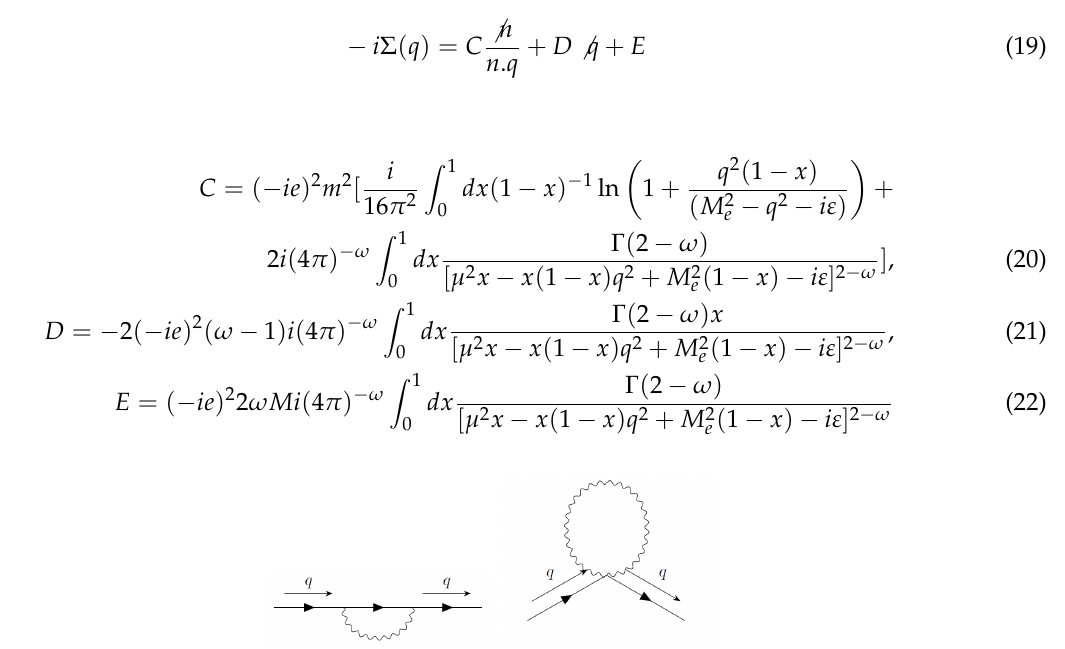
Figure 3. Electron self-energy one loop graphs. The second graph vanishes in the Feynman